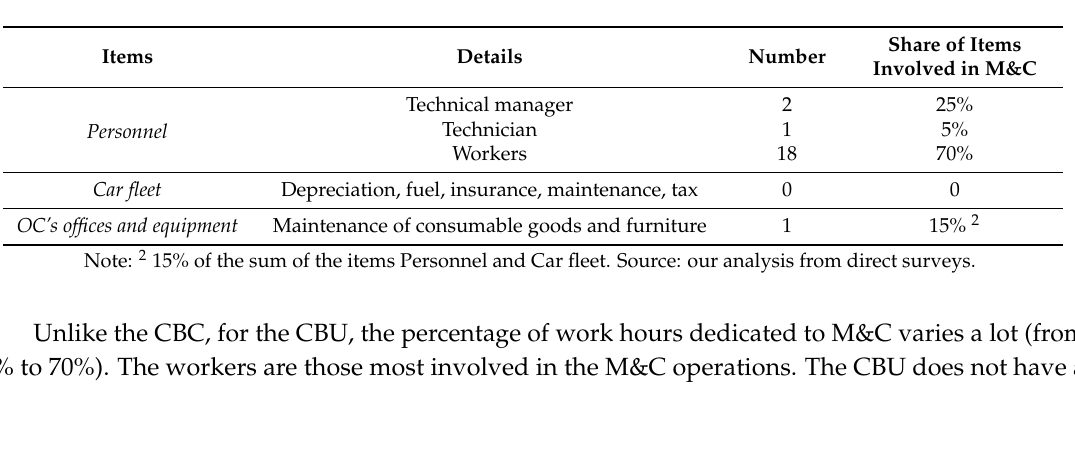
Table 5. CBU allocation shares for the joint